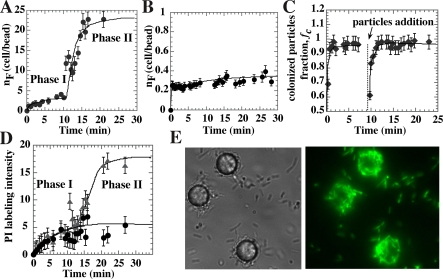
Effect of Curli Production on Early Surface AdhesionAdhesion kinetic curves of MG1655gfpompR234 (A) and MG1655gfpΔcsgA (B). Particles and cells were brought into contact at time t = 0. Cell to particle ratio was around 200 and particle concentration equal to 6 × 106/ml.(C) Colonized particle fraction kinetics are shown for two sequential additions of fresh NH3
+ particles to MG1655gfpompR234 cells. 50 μl of stock particles were added to a cell/particle sample after 9 min incubation once the first colonization phase leveled off.(D) Charge inversion of NH3
+ particle during surface colonization. FL3 intensity in time due to PI adsorption (2 × 10−8 M) is shown for MG1655gfpompR234 (▴) and MG1655gfpΔcsgA (•).(E) Bright field and fluorescence microscope images of MG1655gfpompR234 engaged in second-phase colonization of NH3
+ particles.